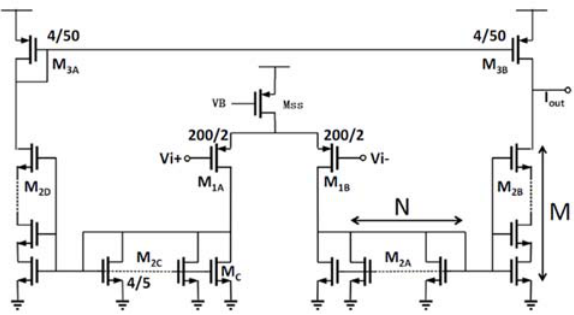
Figure 9. The schematic of the Gm block. [17]